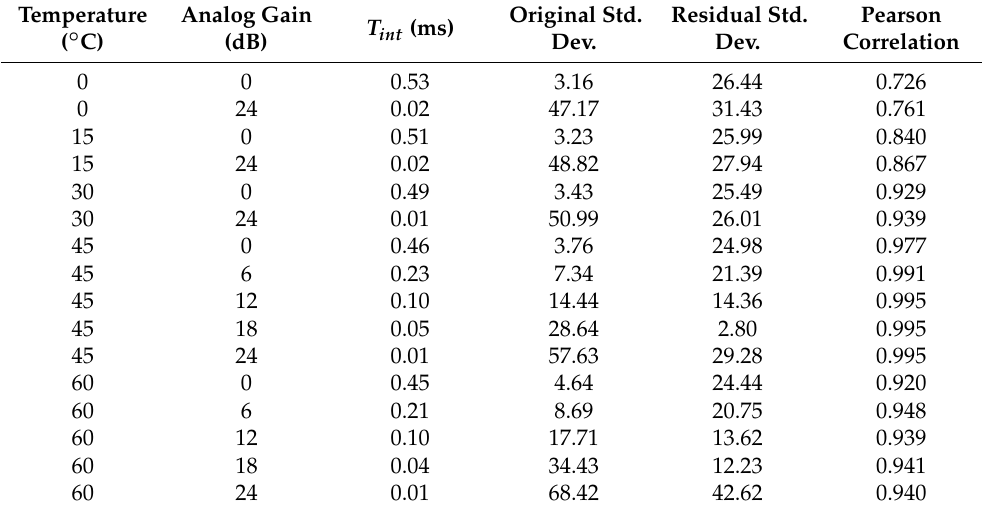
Table 2. SD and Pearson correlation for DSNU correction with a single static reference.